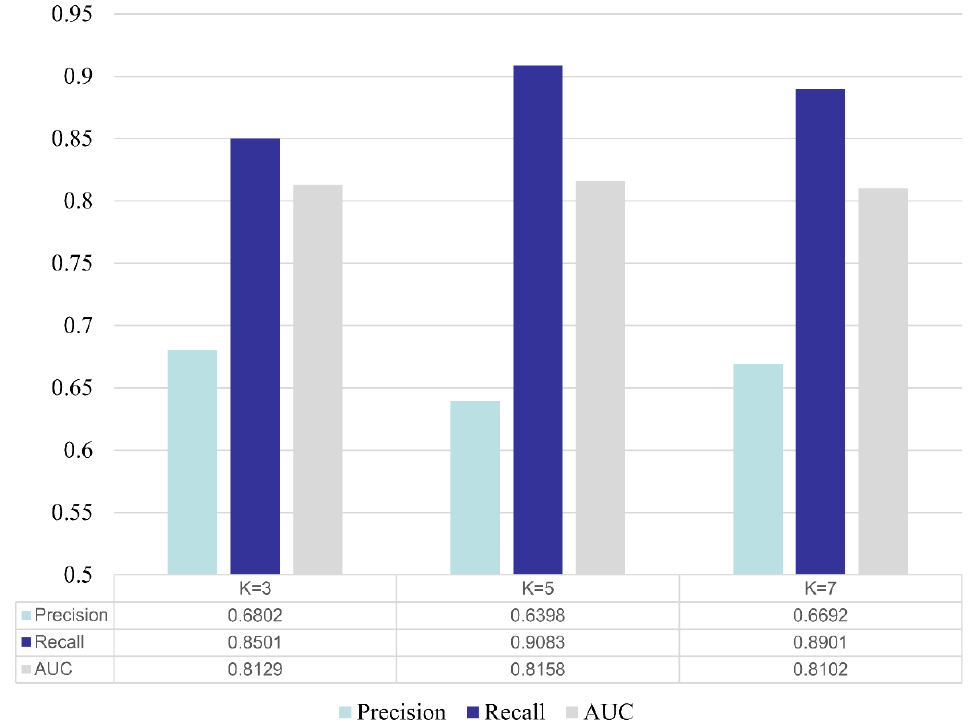
Figure 6. The results of the proposed method under different cluster number.